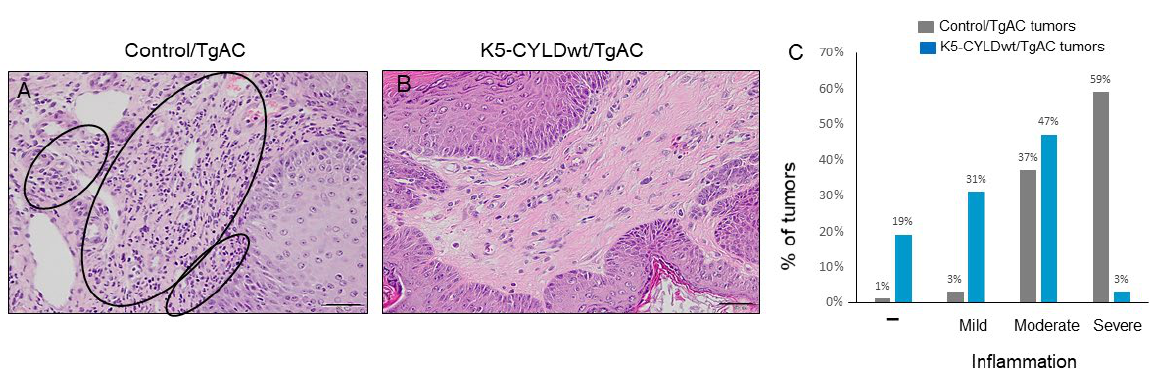
Figure 9. Reduced inflammation in K5-CYLDwt/TgAC tumors. ( A ) Circles indicate abundant inflammatory infiltrates in the stroma of Control/TgAC tumors in contrast to the lesser inflammation detected in K5-CYLDwt/TgAC tumors ( B ). ( C ) Graph showing that most of Control/TgAC tumors (the 96%) presented severe or moderate inflammation, while only 4% did not show important inflammation; by contrast, 50% of tumors developed in K5-CYLDwt/TgAC mice showed low or no signs of inflammation. Data are shown as mean ± SEM by two-tailed t-test; n = 79 Control/TgAC tumors and n = 32 K5-CYLDwt/TgAC tumors. Scale bars : 50 µm ( A , B ).